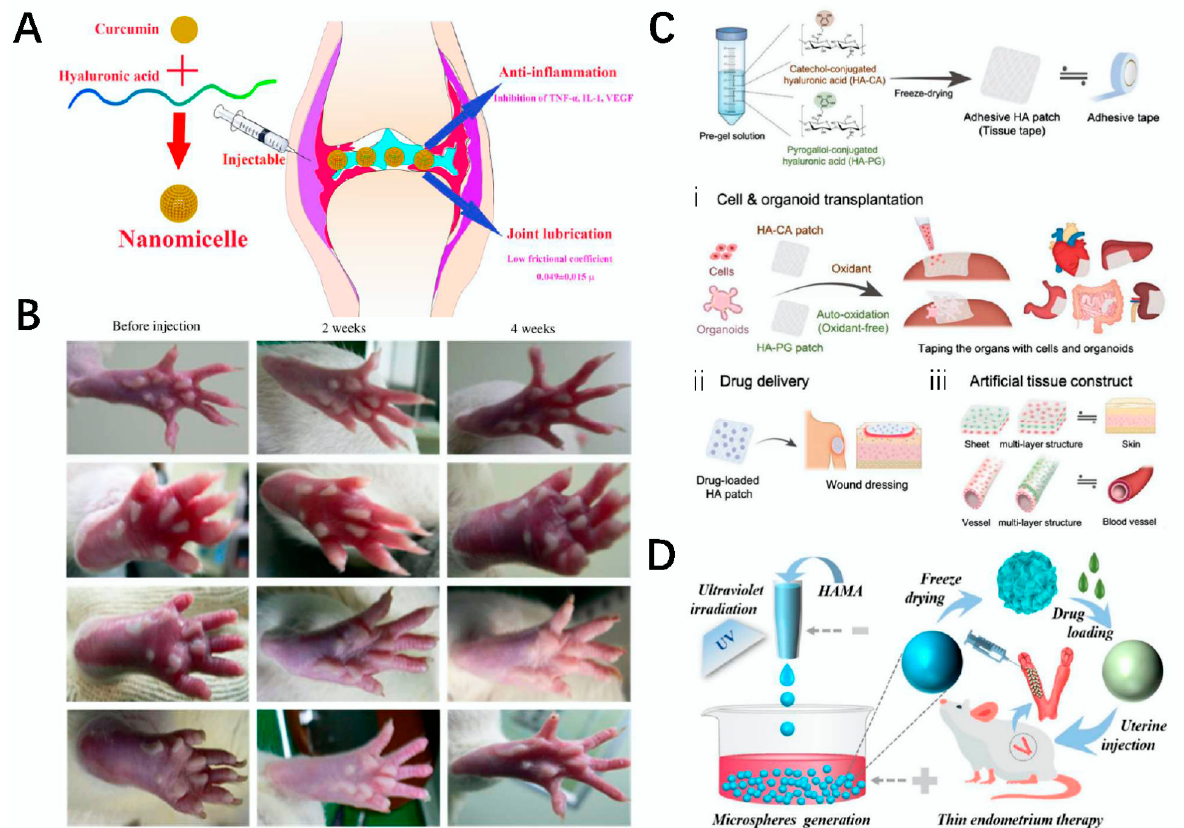
Figure 9. Construction of related polysaccharide materials and its tissue engineering